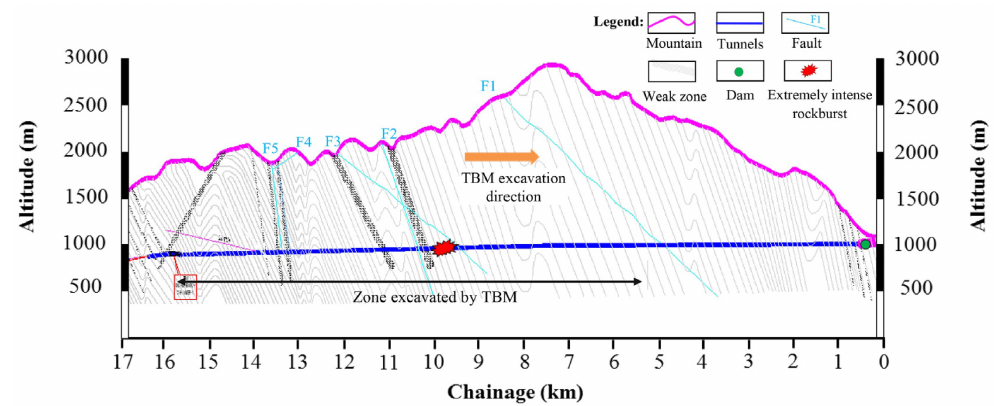
Figure 16. Geological Cross-section along the tunnel in NeJHP (after Li et al. [59]).